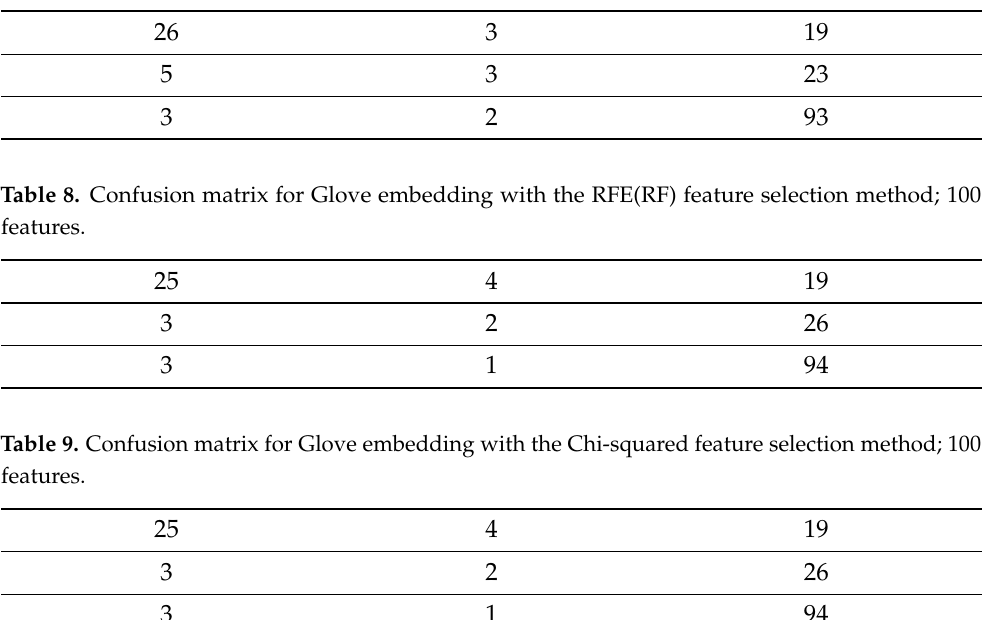
Table 7. Confusion matrix for Glove Embedding with feature selection method of F Classifier, 100 features.